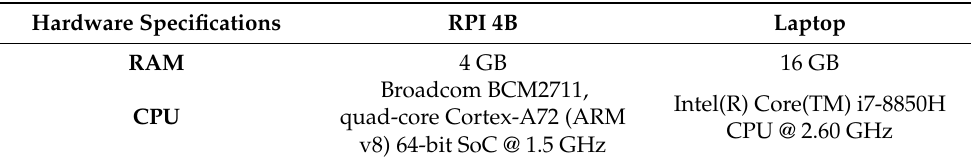
Table 4. Hardware specifications for the experimental environment. Hardware